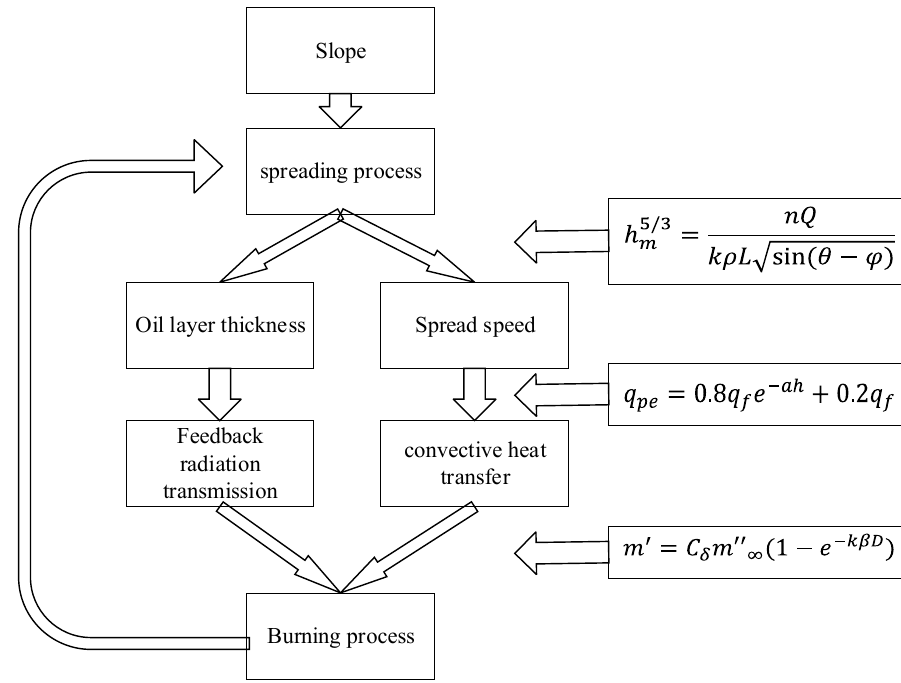
Figure 14. Model showing how a slope affects the spreading and burning processes.